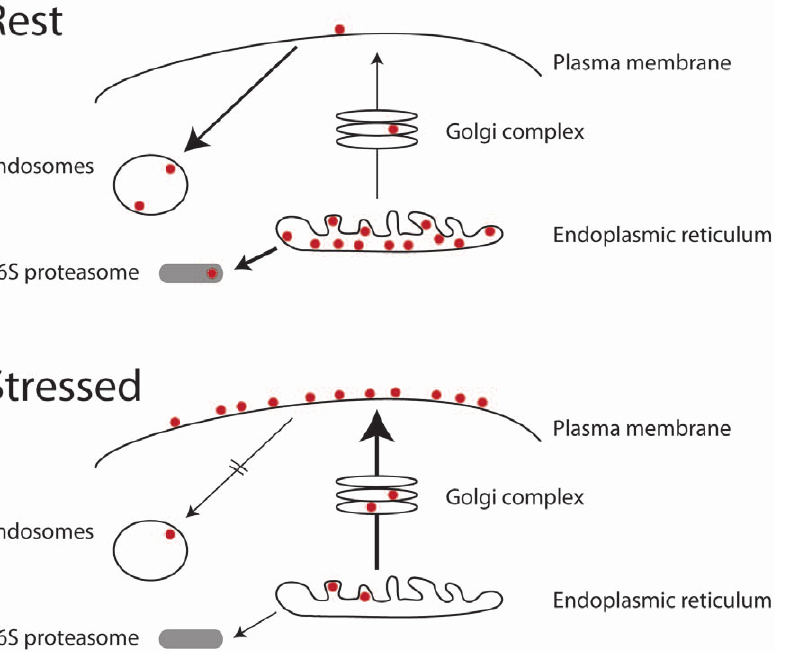
Figure 11. A model for intracellular transport of TP in resting and hydrogen peroxide-challenged cells. At rest (upper panel), most TP is retained in the ER and degraded by the 26S proteasome following dislocation to the cytosol. The small quantities of receptor that do exit the ER and enter into the secretory system are degraded and removed from the cell surface efficiently, presumably by endocytosis. Following exposure to hydrogen peroxide (lower panel), the steady state distribution is altered so that TP levels at the surface are greatly increased. This results from the combination of more efficient ER exit, due to increased chaperone concentrations, and an increased surface half-life. It is presumed that the latter is in part the result of a decrease in endocytosis of TP. TP molecules are shown as maroon dots, and the proteasome as a gray lozenge. Arrow thickness is proportional to flux between destinations.